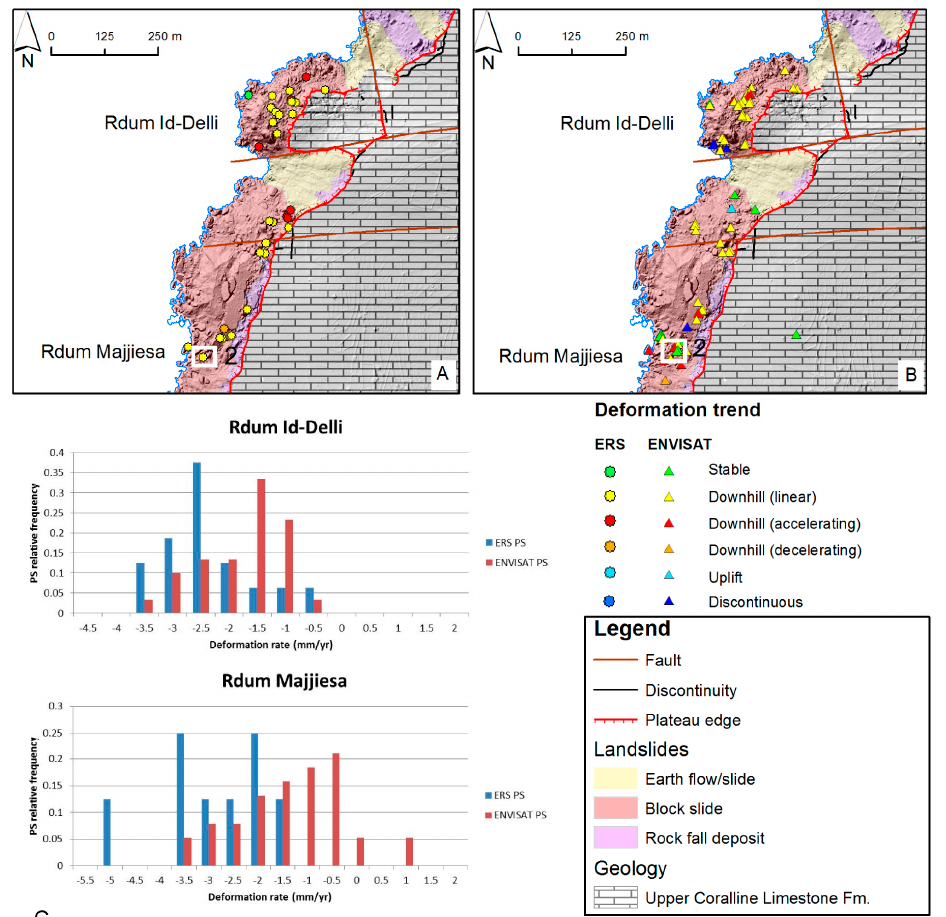
Figure 10. Rdum id-Delli—Rdum Majjiesa landslide map and distribution of the PS, color coded according to the trend classes defined in Figure 4: ( A ) ERS satellite PS deformation trend; ( B ) ENVISAT satellite PS deformation trend; ( C ) Histogram showing the relative frequency of occurrence in each class of movement rate. Blue bars are ERS PS, red are ENVISAT. The white box on the maps locate the PS whose time series are reported in Figure 6b.